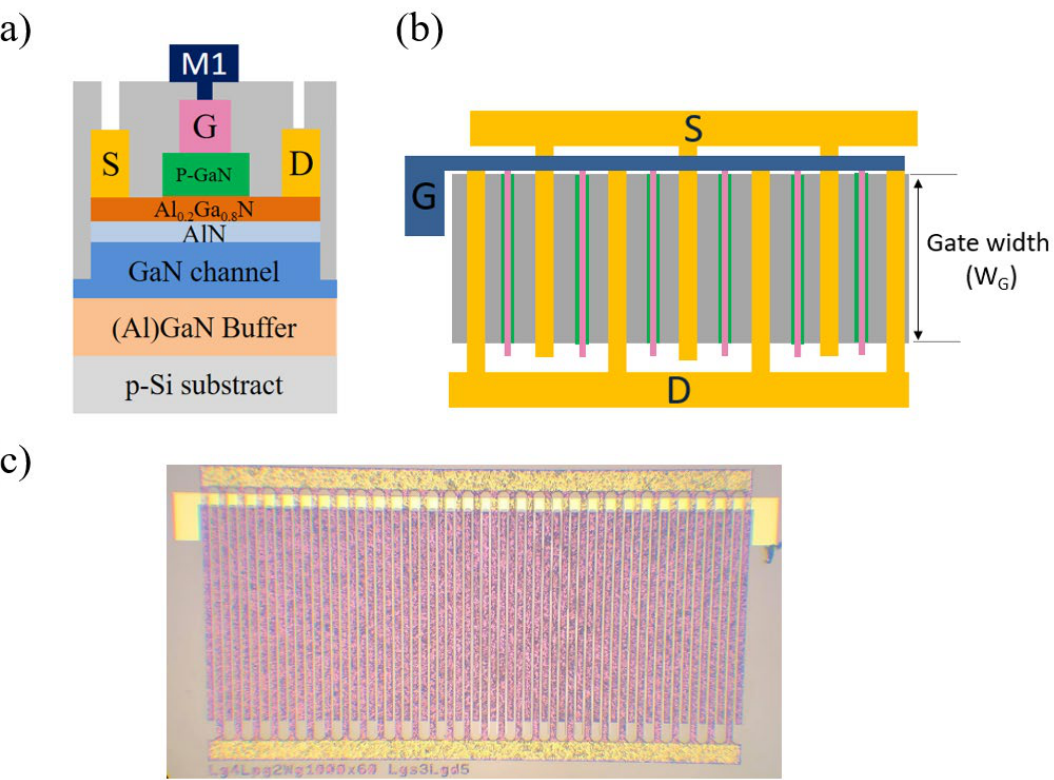
Figure 1. ( a ) Cross section of the p-gallium nitride (GaN) high electron mobility transistors (HEMT) device structure. ( b ) Schematic top view of the p-GaN HEMT device structure. ( c ) Optical micrograph of a realized p-GaN gate HEMT (individual gate width W G /# of fingers = 1000 μm/60, L G = 4 μm, L GD = 3 μm, and L GS = 3 μm).